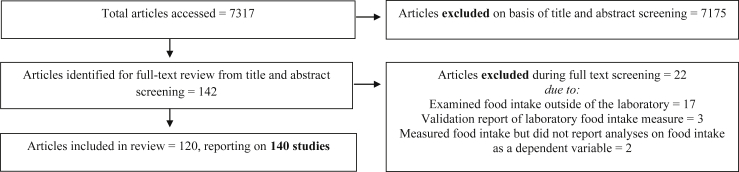
Study identification process.